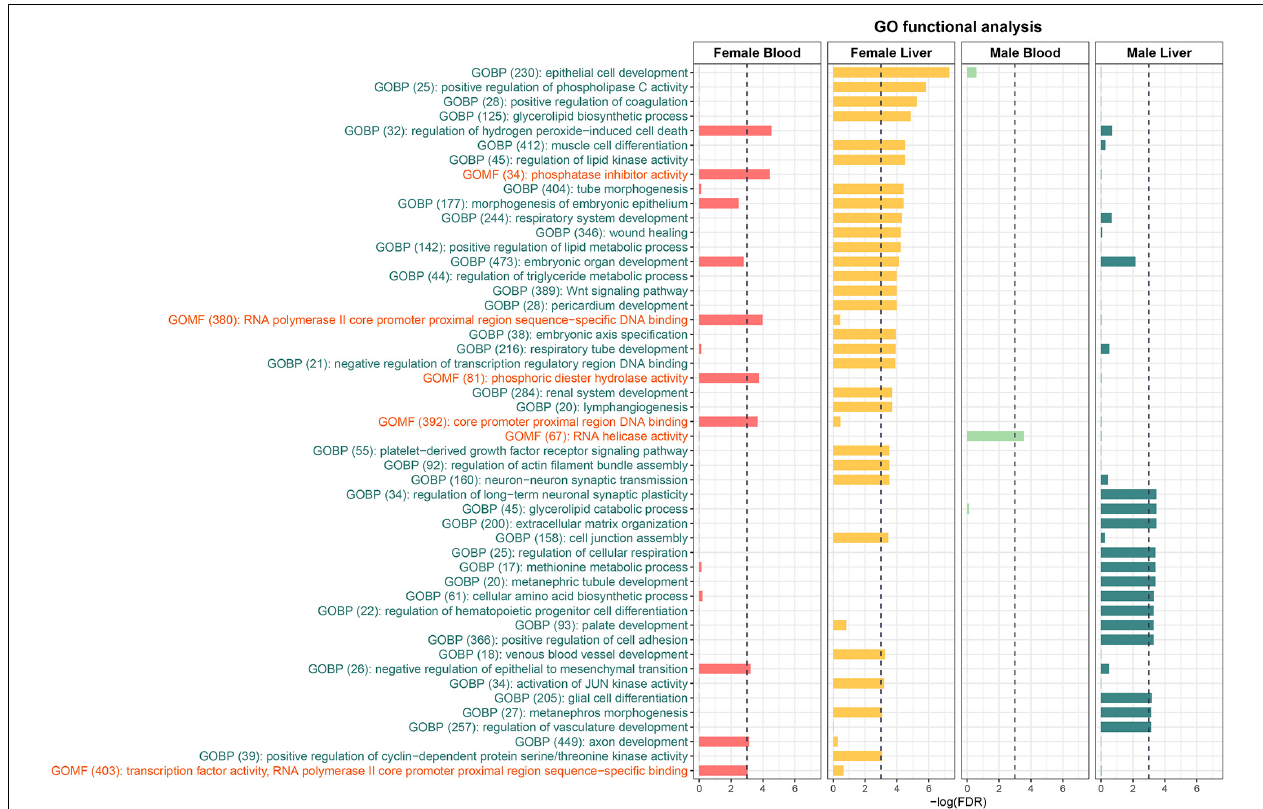
FIGURE 2 | The Enriched GO terms identified from the DMRs. GOBP stands for Gene Ontology Biological Process and GOMF stands for Gene Ontology Molecular Function. No Gene Ontology Cellular Component terms were significantly enriched.